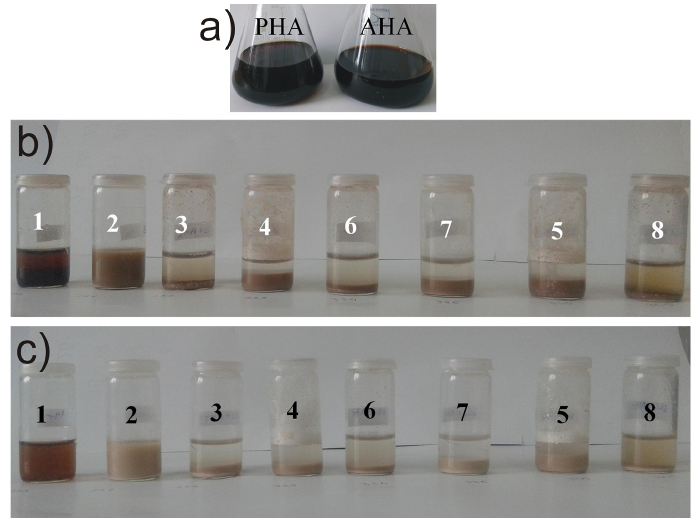
Figure 10. ( a ) Pictures of the two humic acid stock solutions and immobilization tests of ( b ) AHA; and ( c ) PHA, respectively, on various silica supports.